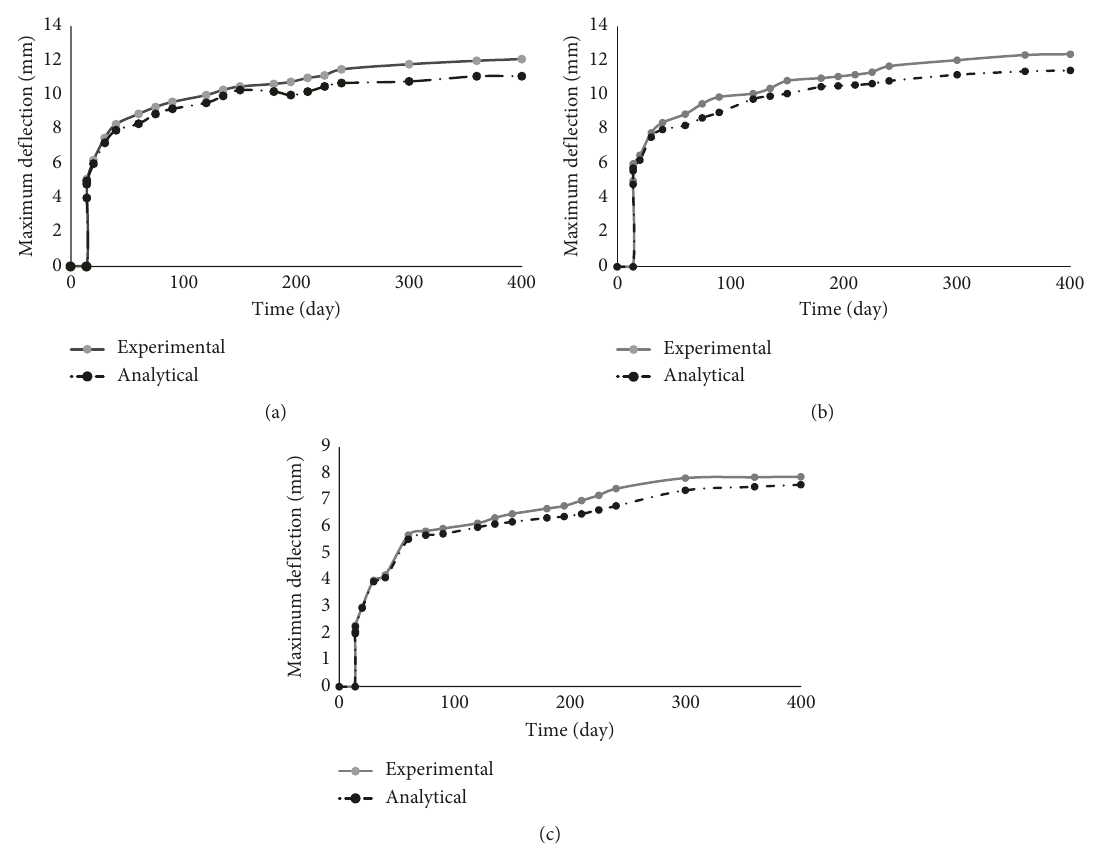
Figure 2: Variations of the maximum deflection with time in experimental and analytical analyses (experimental work by Gilbert [38]): (a) B1-a; (b) B2-a; (c)